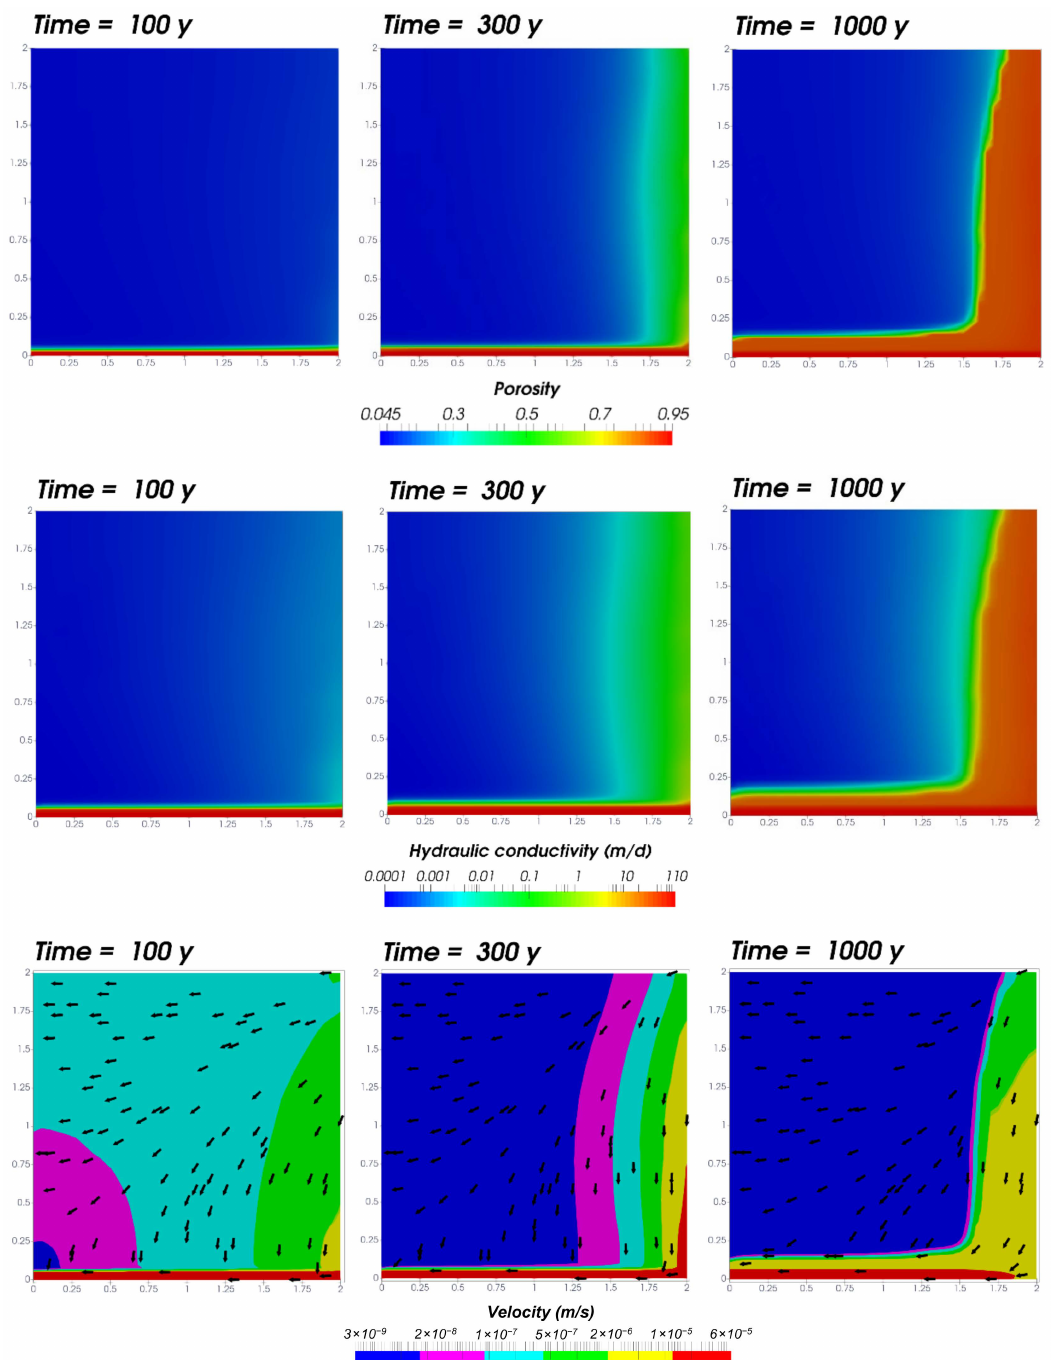
Figure 4. Spatial distribution of the computed porosity ( top ), hydraulic conductivity ( middle ), and flow velocity ( bottom ) after 100, 300, and 1000 years of simulation in scenario 1 using the Kozeny-Carman permeability-porosity relationship. The size of the arrows is not proportional to the magnitude of the flow velocity